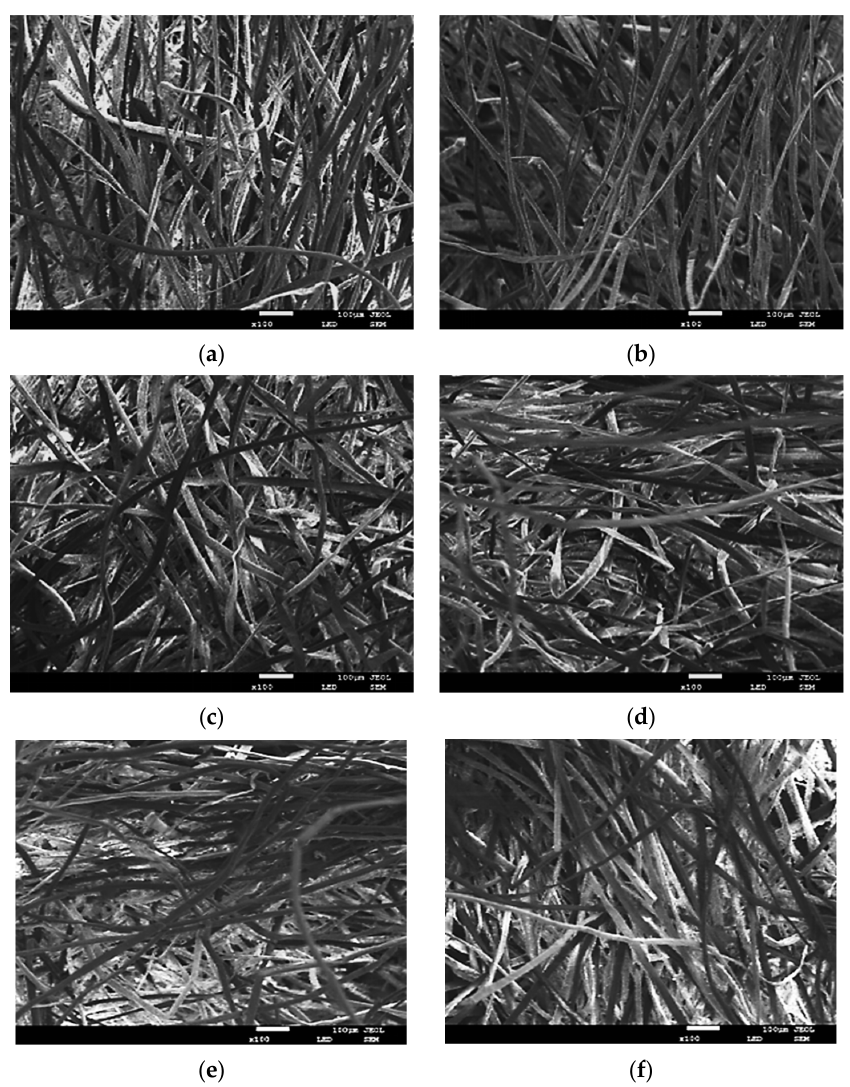
Figure 5. SEM images of composite materials with different volume densities . ( a ) 1# (0.139 g/cm 3 ); ( b ) 2# (0.155 g/cm 3 ); ( c ) 3# (0.172 g/cm 3 ); ( d ) 4# (0.188 g/cm 3 ); ( e ) 5# (0.205 g/cm 3 ); ( f ) 6# (0.205 g/cm 3 ).